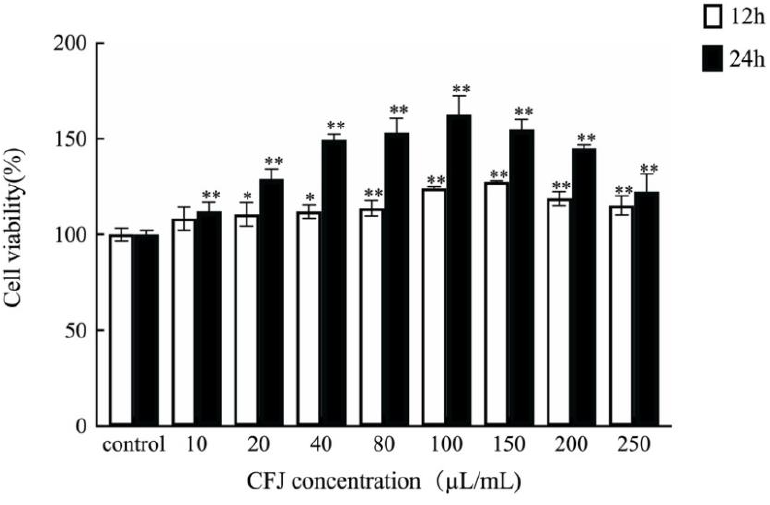
Figure 3. Effects of different concentrations of CFJ on cell survival rates compared with the control group (* p < 0.05, ** p < 0.01).